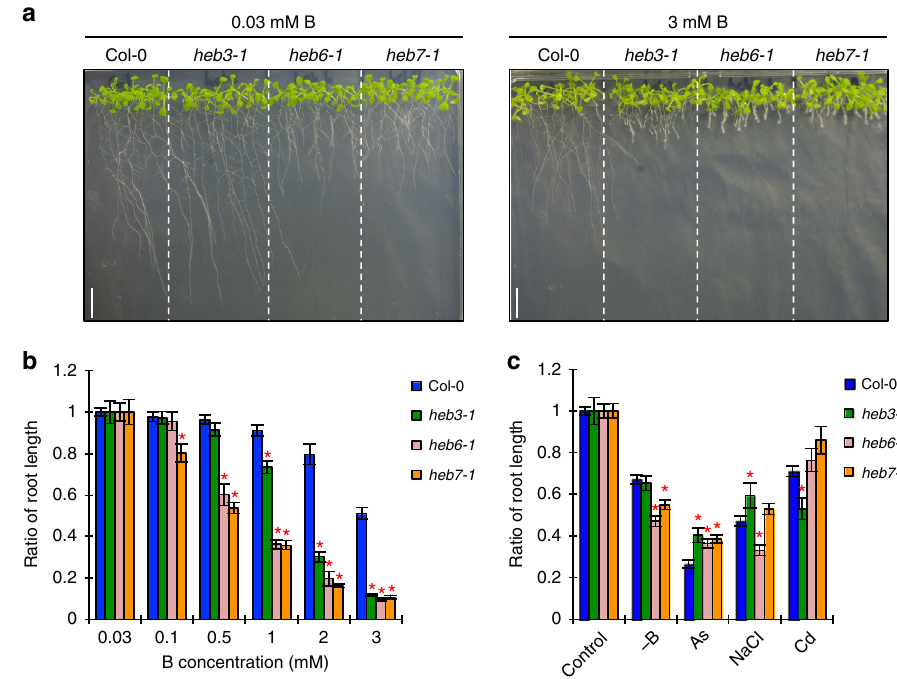
Fig. 1 The heb mutants are speci fi cally hypersensitive to high-B stress. a Short-root phenotypes of heb3-1 , heb6-1 , and heb7-1 mutants grown under normal- (left) and high-B (right) conditions for 14 days. Scale bars, 1 cm. b Dose-dependent sensitivity of heb mutant root growth to high-B stress. Plants were grown on media containing the indicated concentrations of B for 14 days. Values are ratios relative to the value under 0.03 mM B conditions ( n = 13 – 22, average ± s.e.m.; * P < 0.05, compared with Col-0, Student ’ s t -test). c Sensitivity of Col-0 and heb mutant root growth to various elemental stresses. Plants were grown on media containing no B ( − B), 15 μ M arsenic (As), 75 mM sodium chloride (NaCl), and 100 μ M cadmium (Cd) for 14 days. Values are ratios relative to the value under the control conditions ( n = 13 – 20, average ± s.e.m.; * P < 0.05, compared with Col-0, Student ’ s t